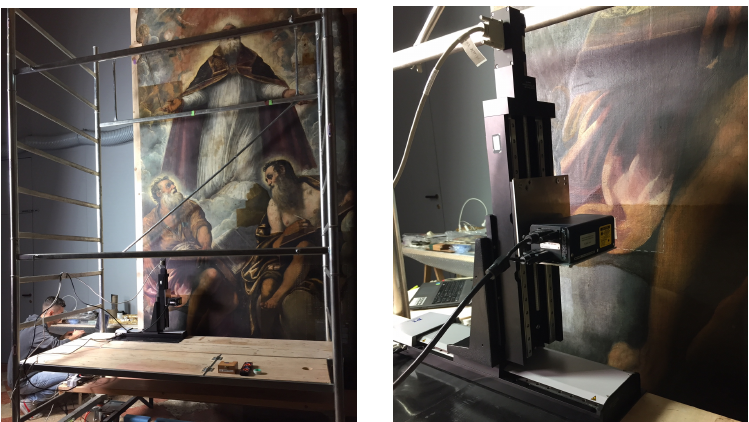
Figure 2. Scanning profilometry on the Tintoretto masterpiece Saint Martial in Glory , altarpiece from the church of San Marziale in Venice (Italy). The conoscopic holography sensor is mounted on micrometric stages to scan the painting in the vertical plane at safe working